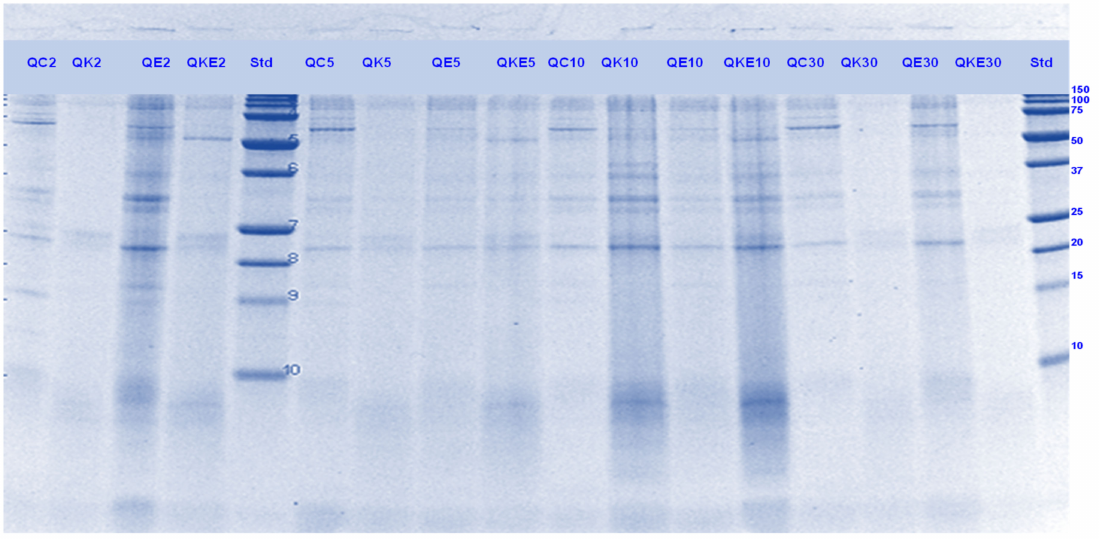
Figure 16. Tricine SDS-PAGE electrophoretogram of quinoa (Q) digests after 2, 5, 10, and 30 min of simulated oral-gastric digestion in the presence or absence of Hayward (K) kiwifruit extract. QC, Quinoa (Q) control without any digestive enzymes; QK, with added green kiwifruit extract but no digestive enzymes; QE, with digestive enzymes but no added kiwifruit extract; QKE, with both digestive enzymes and green kiwifruit extract. Numbers 2, 5, 10, and 30 are the gastric digestion times following 2 min of oral digestion. Bands (1–10) in the molecular weight standard lane correspond to